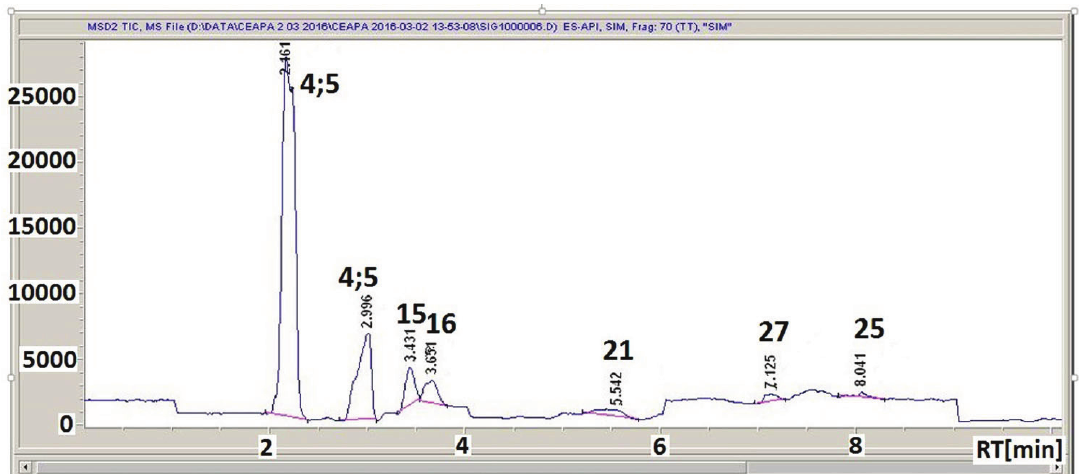
Figure 4: HPLC-MS thiosulfinates profile of the A. cepa extract - lyophilized formulations; 4;5 , MeS(O)S 1-propenyl ( E,Z ); 15 , n -PrS(O)S 1-propenyl-( E ); 16 , n -PrS(O)S 1-propenyl-( Z ); 21 , trans- zwiebelane; 27, n- PrS(O)CHEtSS-1propenyl; 25 ,